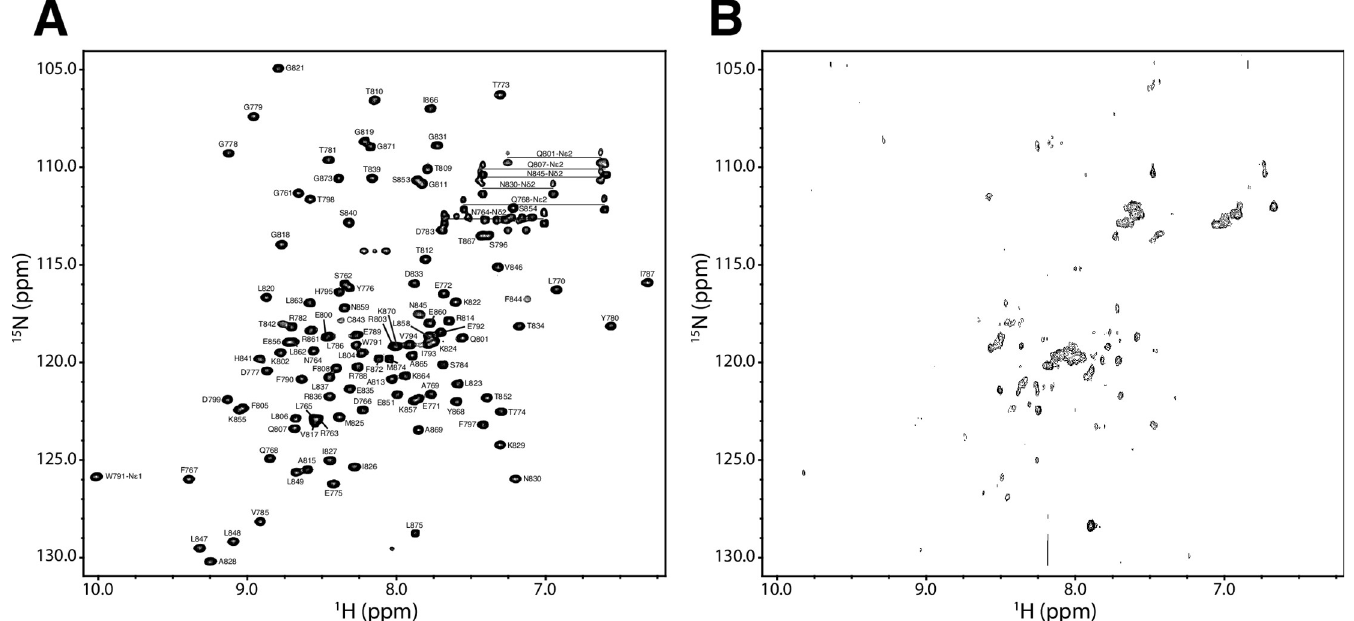
Fig 3. The I827K substitution destabilizes the 3D fold of E6AP C-lobe (residues 761–875). (A) The assigned 1 H- 15 N-HSQC spectrum of 3.5 mM human E6AP catalytic C-lobe (residues 761–875) using the one-letter amino acid code and residue number according to the human E6AP sequence. The spectrum was determined using standard 3D heteronuclear experiments, and side chain amides for asparagine and glutamine are connected with a horizontal line. (B) The E6AP C-lobe I827K sample was collected under identical conditions as the wild-type except it was only 188 μ M and increased transients collected due to the inherent instability of the protein. The decreased signal intensity and partial collapse amide peaks represent the aggregation of the protein caused to the I827K residue substitution. The NMR samples contained 20 mM